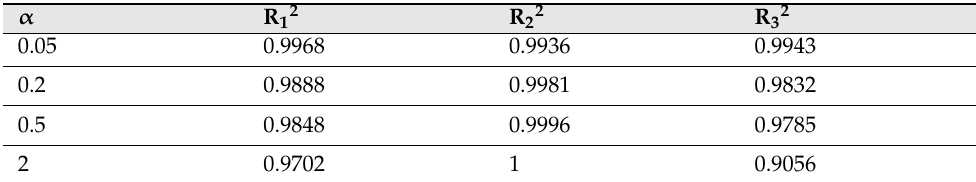
Table 1. Correlation coefficients versus value of parameter α corresponding to example 1.